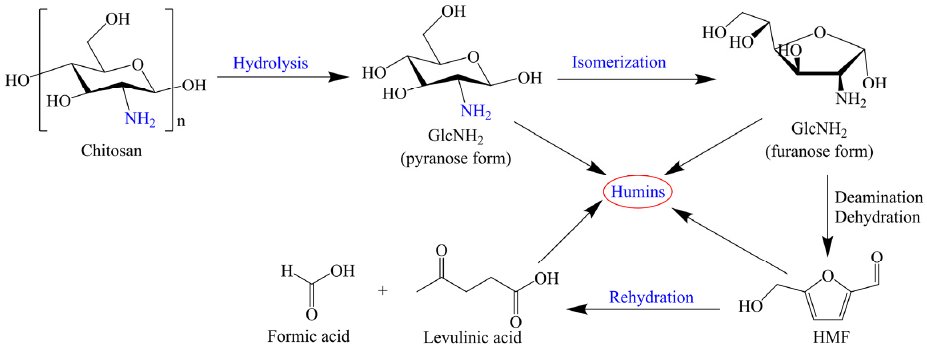
Table 1. Catalytic conversion of chitin biomass to HMF over Bronsted acid